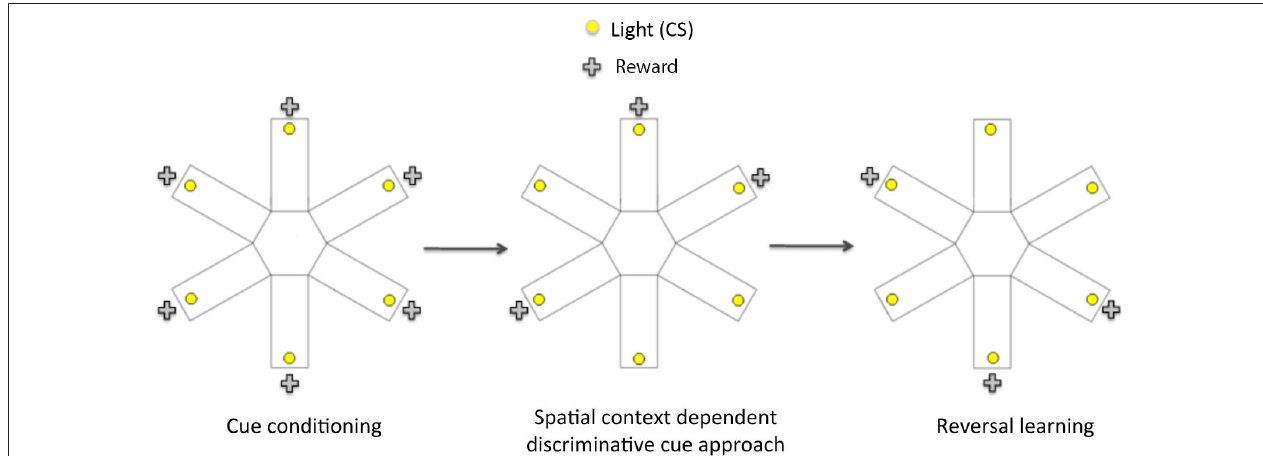
locations (arms), and to withhold their response to a CS presented in three non-rewarded locations. Following the acquisition of discriminative cue approach, rats were tested on a conditioned place preference (CPP) test to establish if they had learnt the reward-associated locations. In the final phase (reversal learning), rats were trained to respond to CS presented in previously non-rewarded locations to obtain reward. At the end of reversal learning, they were given another CPP test to assess the acquisition of the new reward-associated